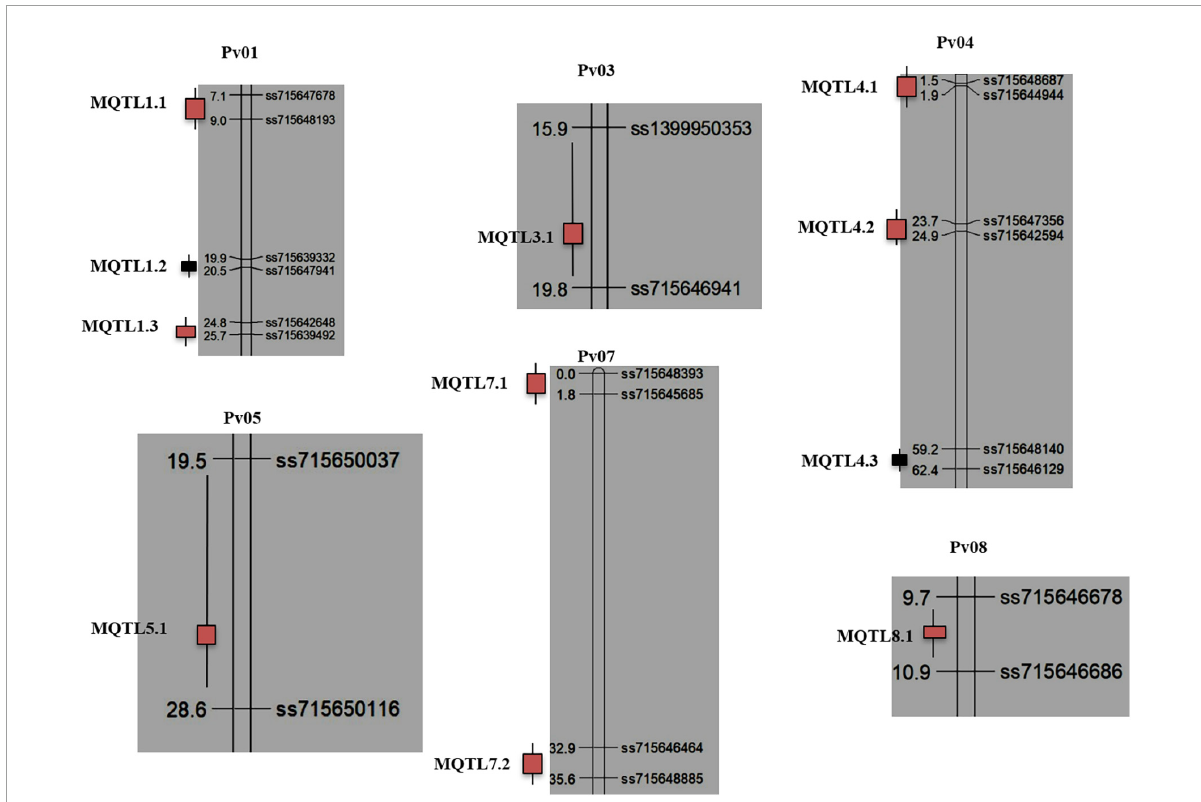
FIGURE2 Distribution of 11 MQTLs on 06 common bean chromosomes identified in the study. The boxes on the right side of each chromosome reflect the placements of MQTLs (with the name of the MQTL in each case). The MQTLs highlighted with red color are MQTLs validated through GWAS, while as MQTLs highlighted with black could not be validated. Distances in cM are given to the left of each bar representing a chromosome, and pairs of flanking markers are given to the right of each